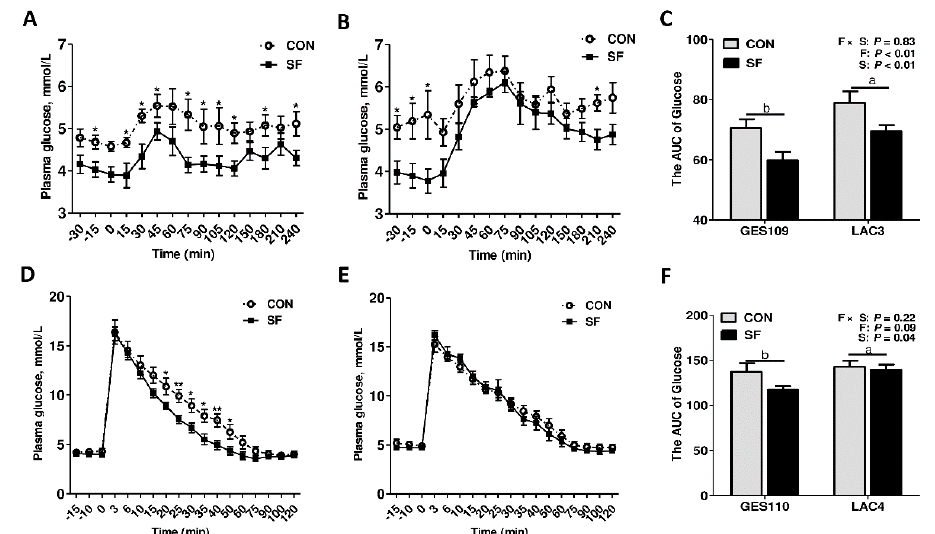
Figure 5. Effects of soluble fiber during gestation on insulin sensitivity of sows. ( A – B ) The plasma glucose concentrations of sows after meal test at day 109 of gestation (GES109) ( A ) and day 3 of lactation ( B ). ( C ) The area under curve of plasma glucose after meal tests at day 109 of gestation and day 3 of lactation. ( D – E ) The plasma glucose concentrations of sows after glucose tolerance tests at day 109 of gestation ( D ) and day 3 of lactation ( E ). ( F ) The area under curve of plasma glucose after glucose tolerance tests at day 109 of gestation and day 3 of lactation. Data are expressed as mean ± SEM ( n = 8). * p < 0.05; ** p < 0.01. a-b, significant effect of breeding stage ( p < 0.05; values with different lowercase letters are significantly different). GES109, day 109 of gestation; LAC3, day 3 of lactation. CON, control diet; SF, 2.0% soluble fiber combination diet.